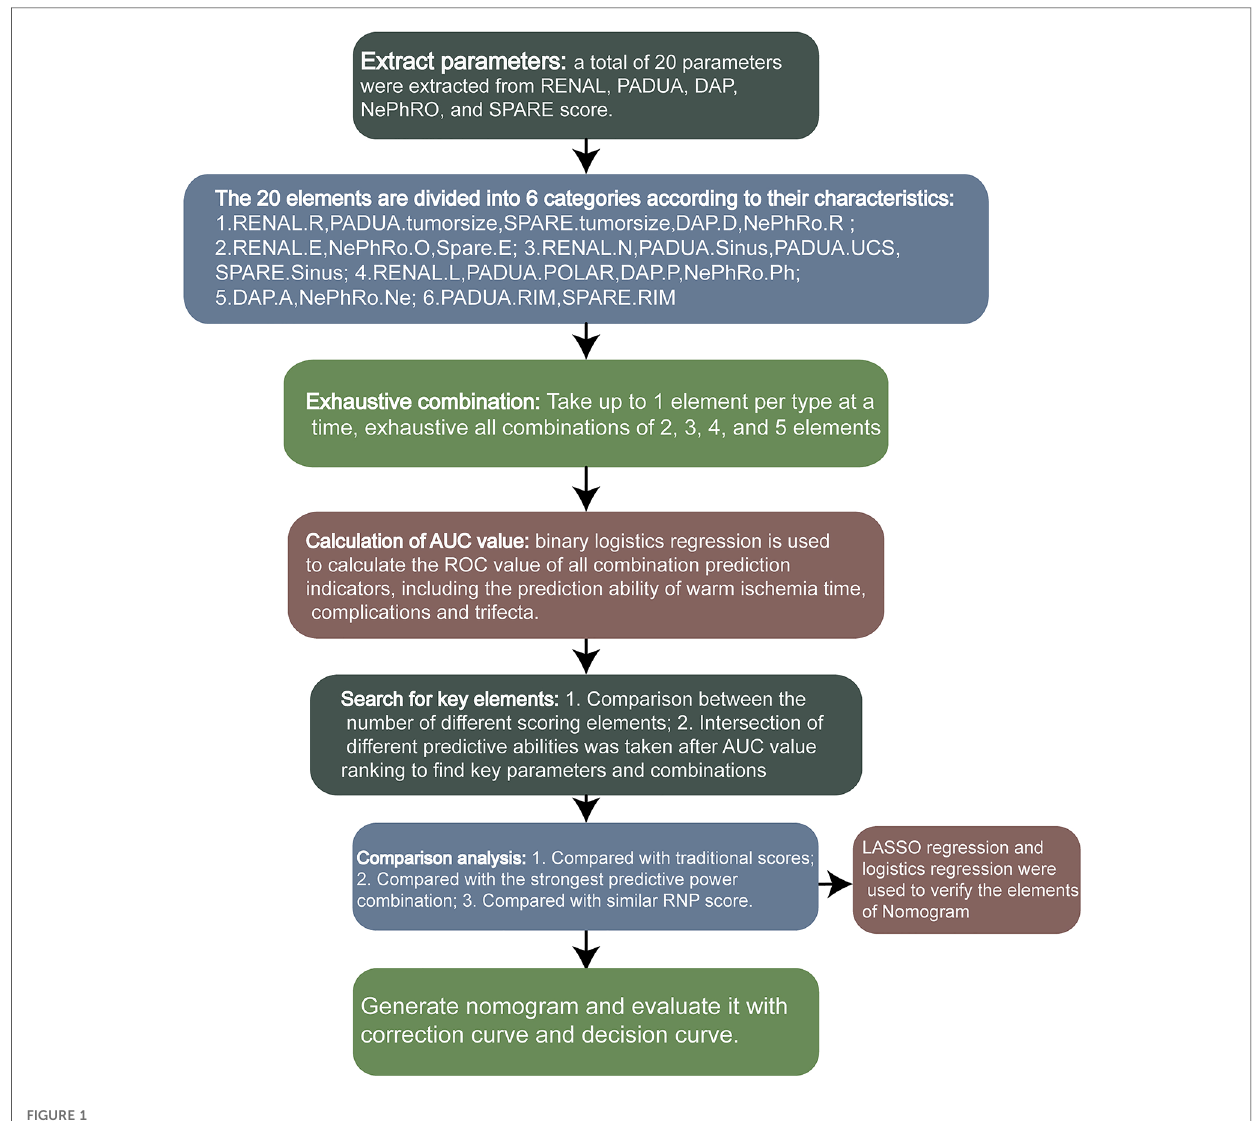
FIGURE 1 The analysis fl